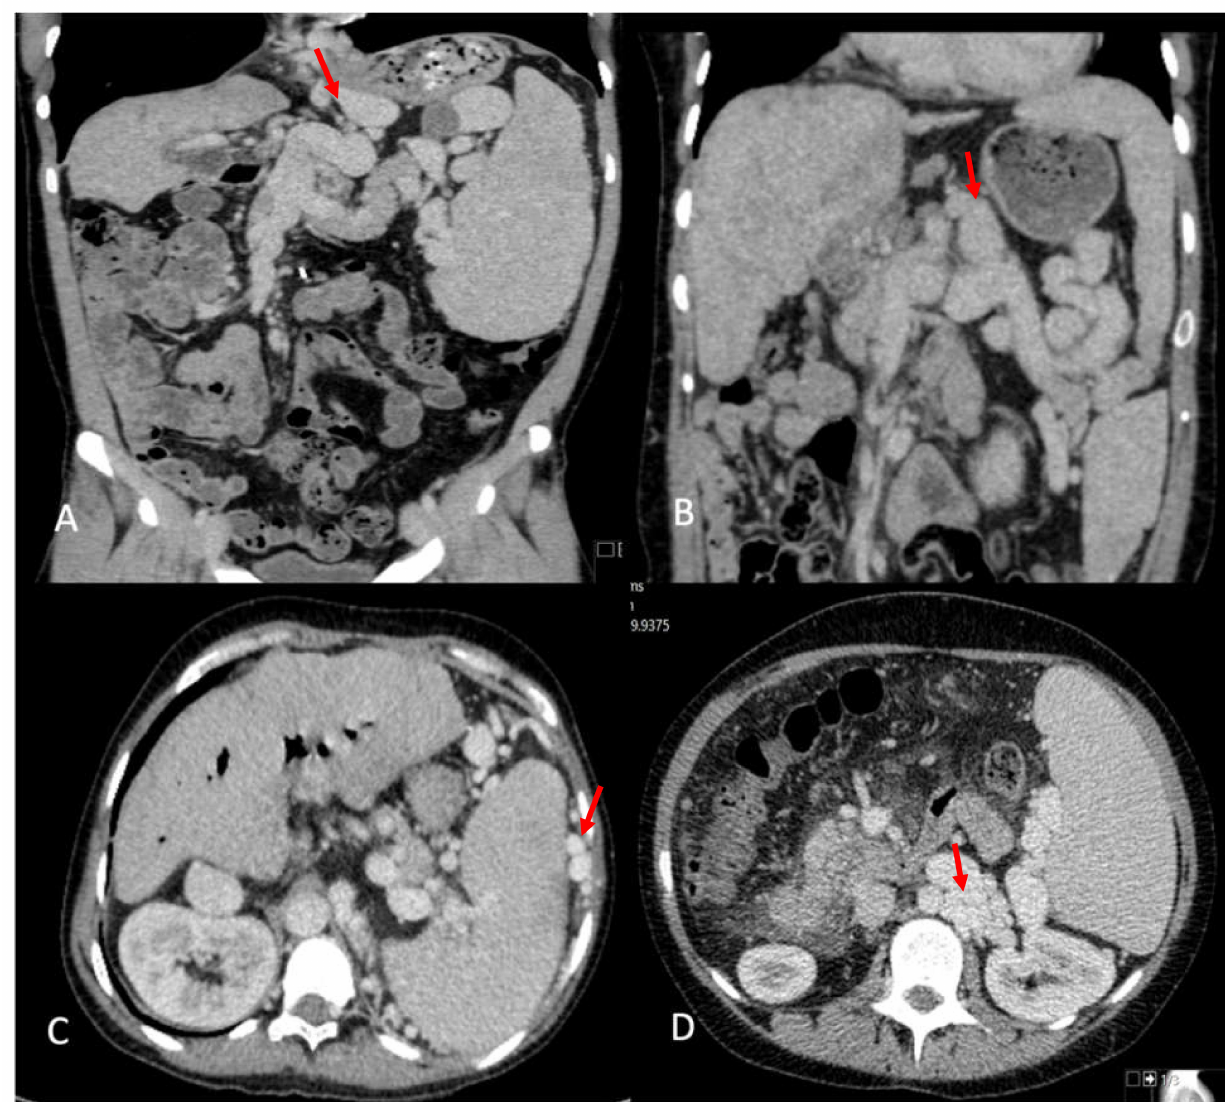
Figure 2. Visceral portosystemic shunts on imaging. ( A ) Left gastric vein varix. ( B ) Lieno-renal shunt. ( C ) Perisplenic varices. ( D ) Retroperitoneal